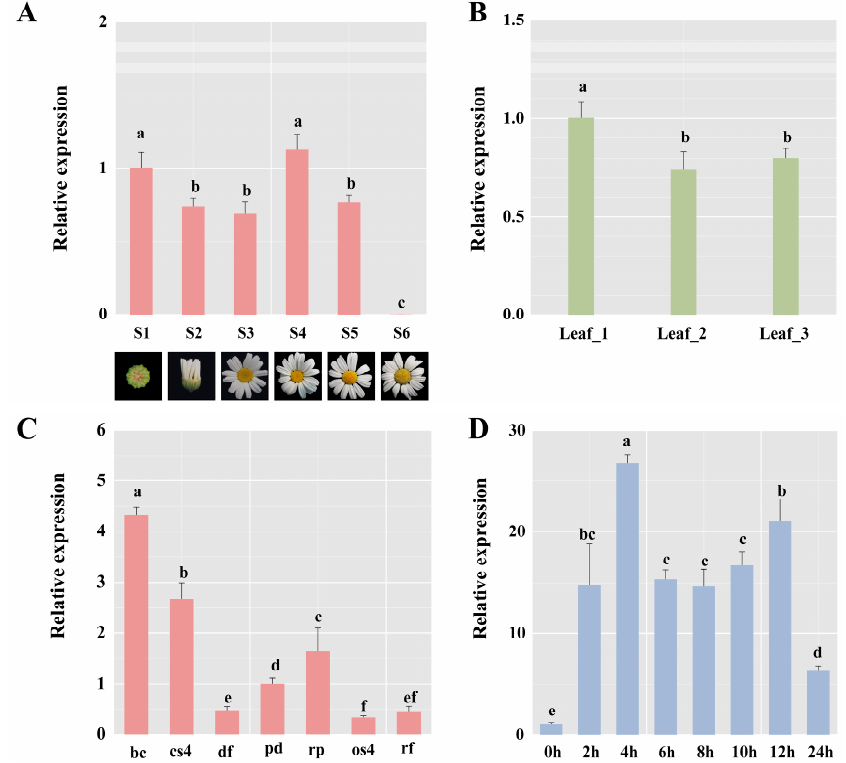
Figure 2. Expression distribution of TcbHLH14 in T. cinerariifolium tissues. RT-qPCR analysis of TcbHLH14 transcript abundance in leaf and flower tissues at different developmental stages. ( A ) Stage 1 (S1, bud), Stage 2 (S2, half open white petalled ray florets), Stage 3 (1st row of the yellow disc-florets), Stage 4 (S4, half rows of the yellow disc-florets), Stage 5 (S5, all rows of the yellow disc-florets open), Stage 6 (S6, withering flowers). ( B ) Leaf 1 (L1, width of 5–10 mm), Leaf 2 (L2, width of 15–20 mm), Leaf 3 (L3, width > 25 mm). ( C ) Expression level normalized against the pedicel transcript level in the S2 flower stages (bc: bract; pd: pedicel; rp: receptacle; rf: ray floret; df: disc floret) and S4 flower stages (os4: fully open ray floret; cs4: unopened ray floret). ( D ) Expression analysis of TcbHLH14 after MeJA treatment of T. cinerariifolium leaves. Different lower-case letters indicate significant differences ( p < 0.05) from one-way ANOVA followed by Tukey post hoc test.